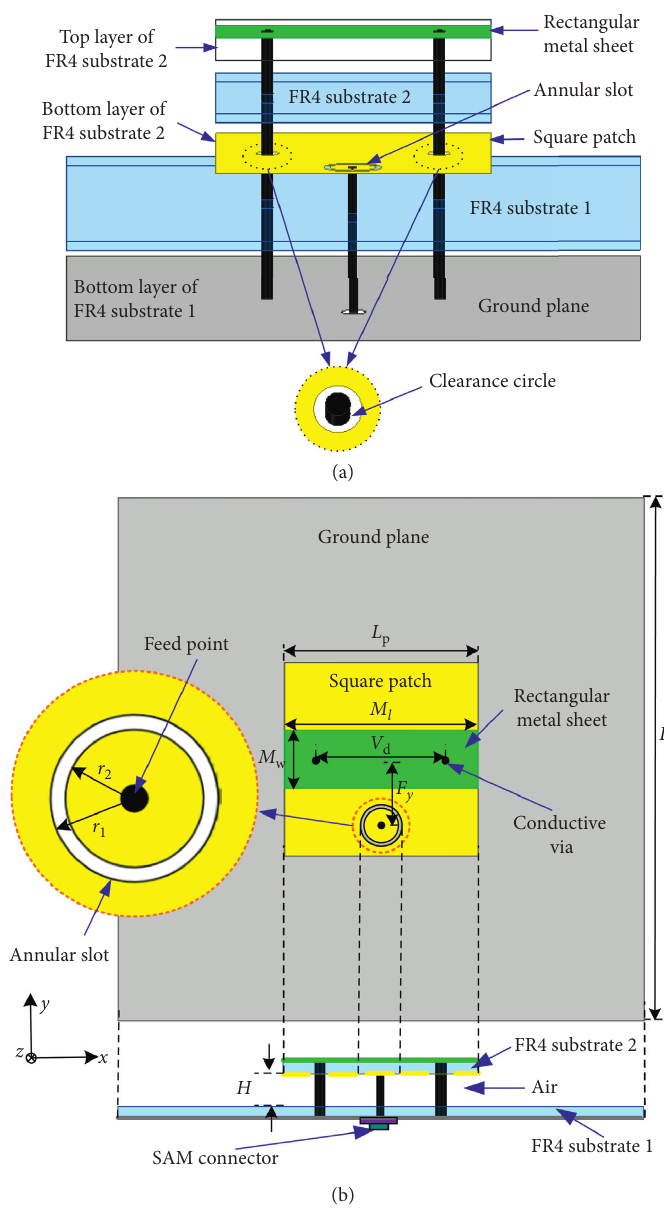
Figure 1: Configuration of the proposed antenna: (a) exploded view; (b) top view and size view. L M l � 24 mm, M w � 7.2mm, V d � 15mm, H � 4mm, r 1 � 2.5mm, and r 2 �